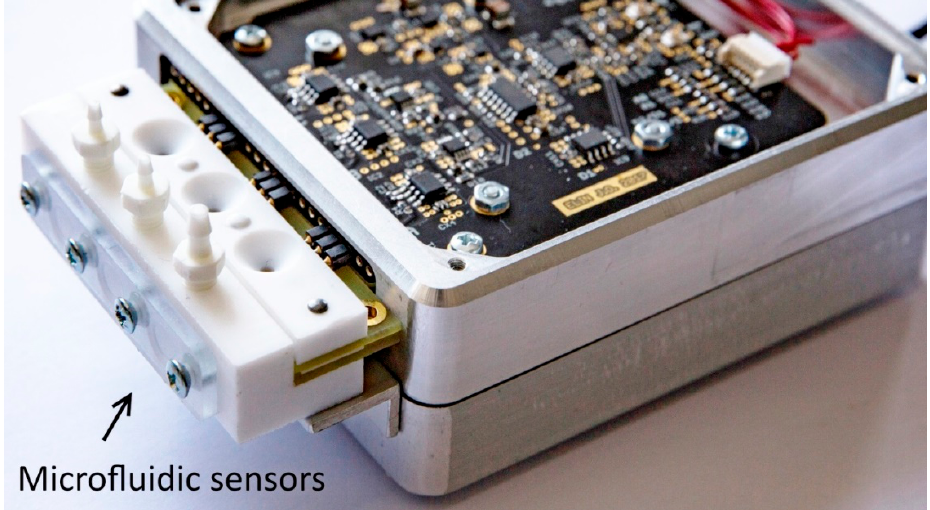
Figure 4. Analyzer with the 3-channel sensor exposing the response chain’s module of the front-end (top cover removed). The PCB of the excitation module is fixed directly underneath the response module’s PCB. Signal processing module AD2 with AD and DA converters, logical IO, and communication capabilities is situated in a lower part of the aluminum case, separated with a partitioning wall for shielding.